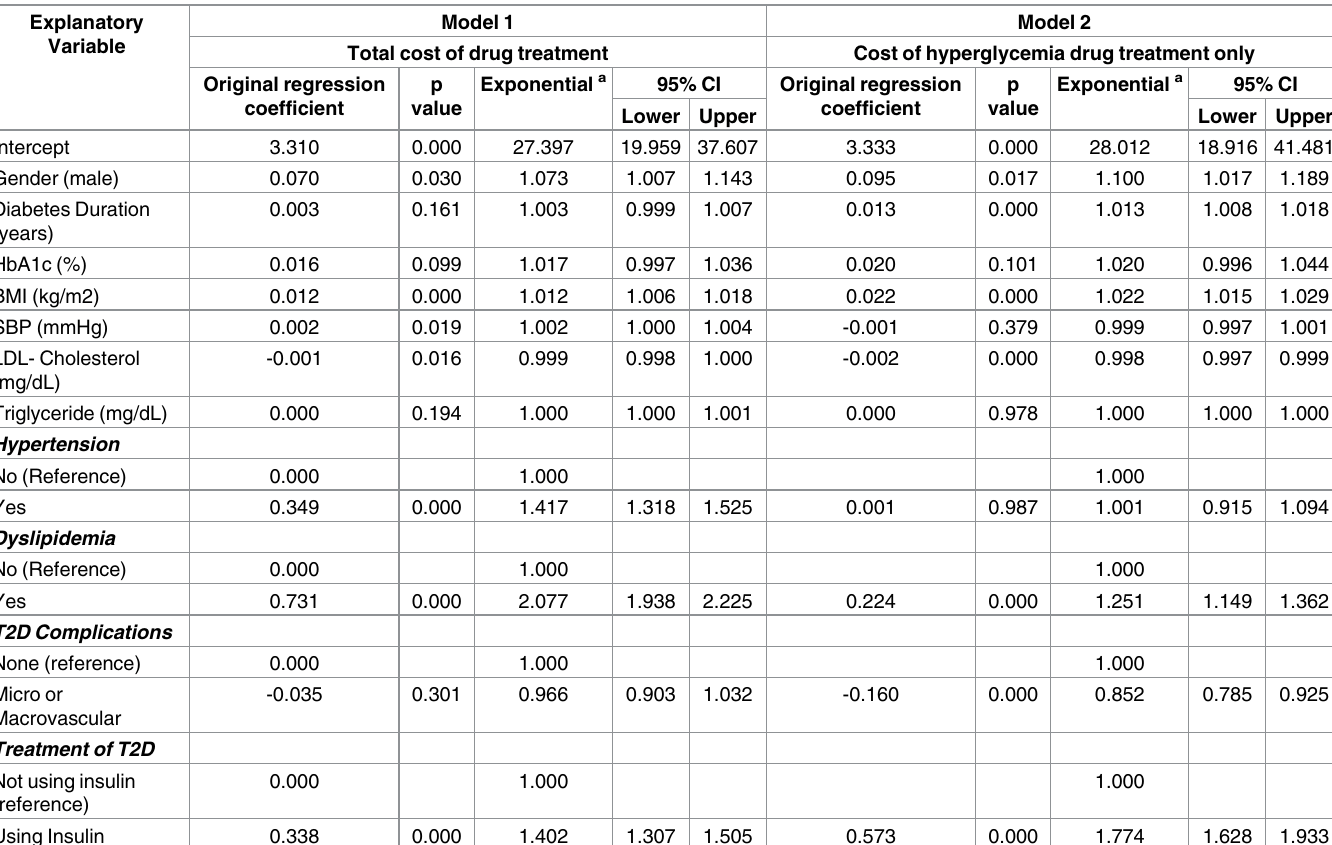
Table 4. Multivariable regression